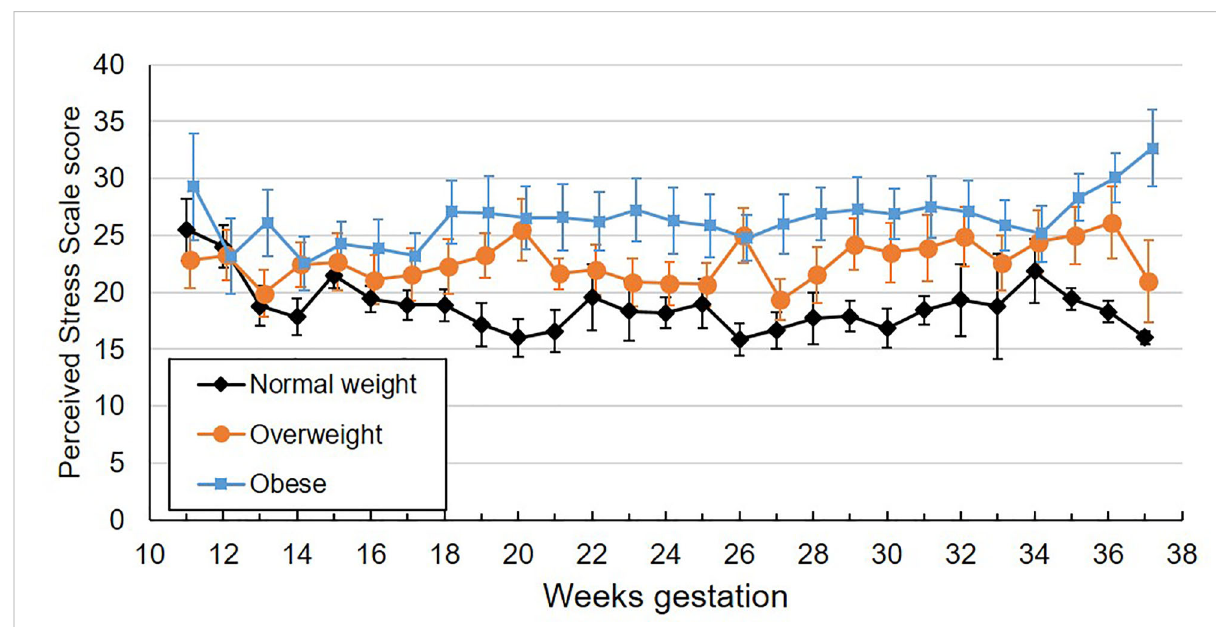
FIGURE 2 Mean weekly perceived stress scale scores across gestation by maternal pre-pregnancy BMI category. Values are mean ± standard